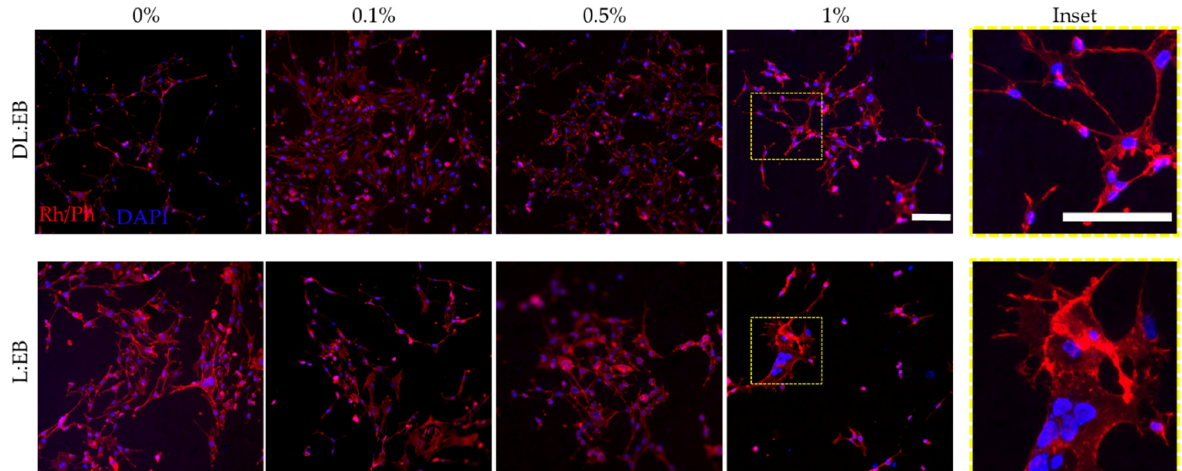
Figure 5. Immunostainning against rhodamine/phalloidin (Rh/Ph) and DAPI showing the morphol- ogy of the astrocytes cultured over L:EB and DL:EB containing increasing amounts of CNT after 48 h. Scale bar 100 μ m in the micrographs and the insets .